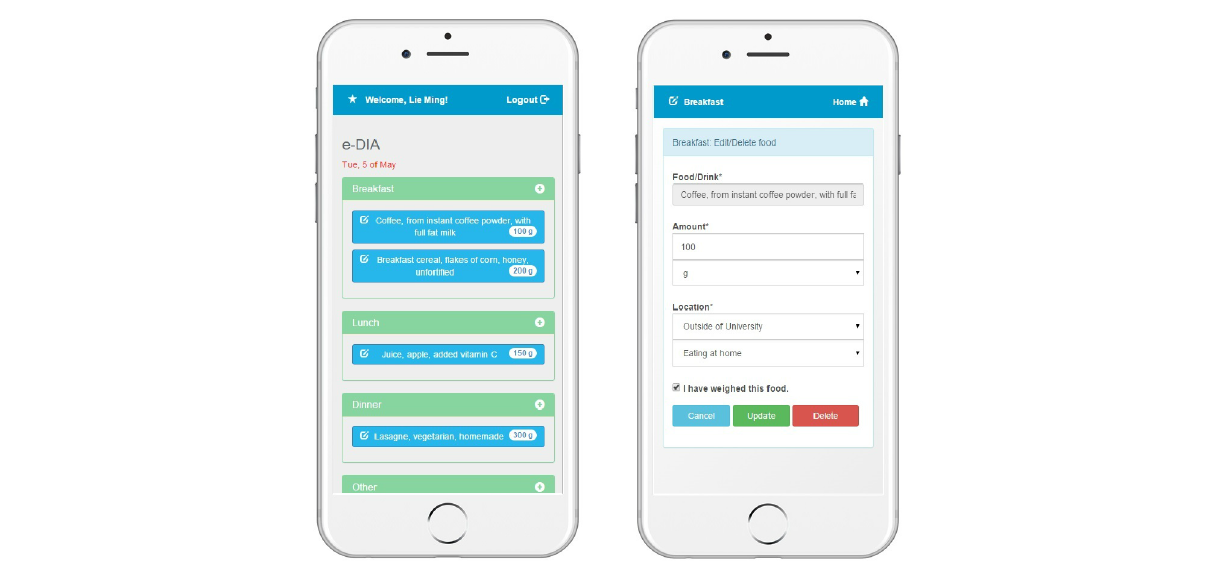
Figure 2. Screenshots of the electronic Dietary Intake Assessment (e-DIA)